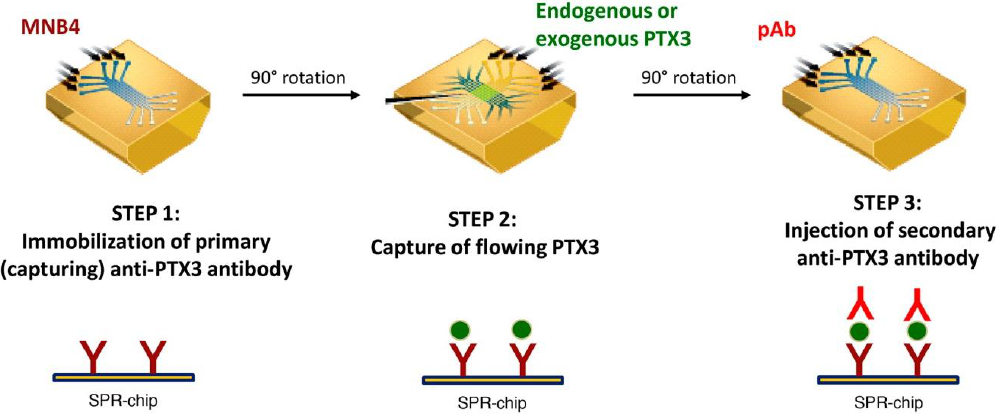
Figure 1. Schematic representation of SPR-based immunoassay for PTX3